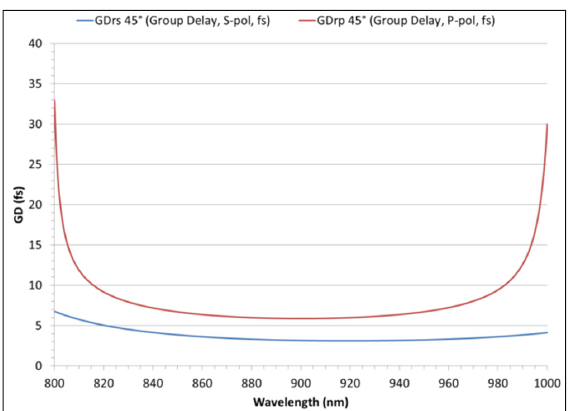
Figure 4. Group delay (GD) on reflection as a function of wavelength for 45° AOI, Spol and Ppol, for the BBHR coating design.